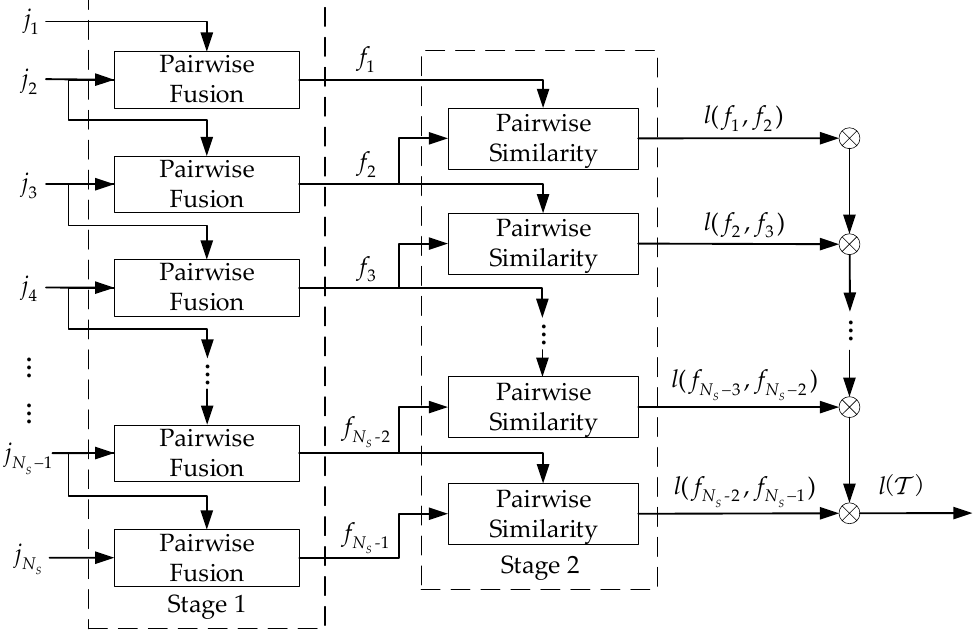
Figure 3. Flow graph of likelihood function calculation strategy for mono-tracks.